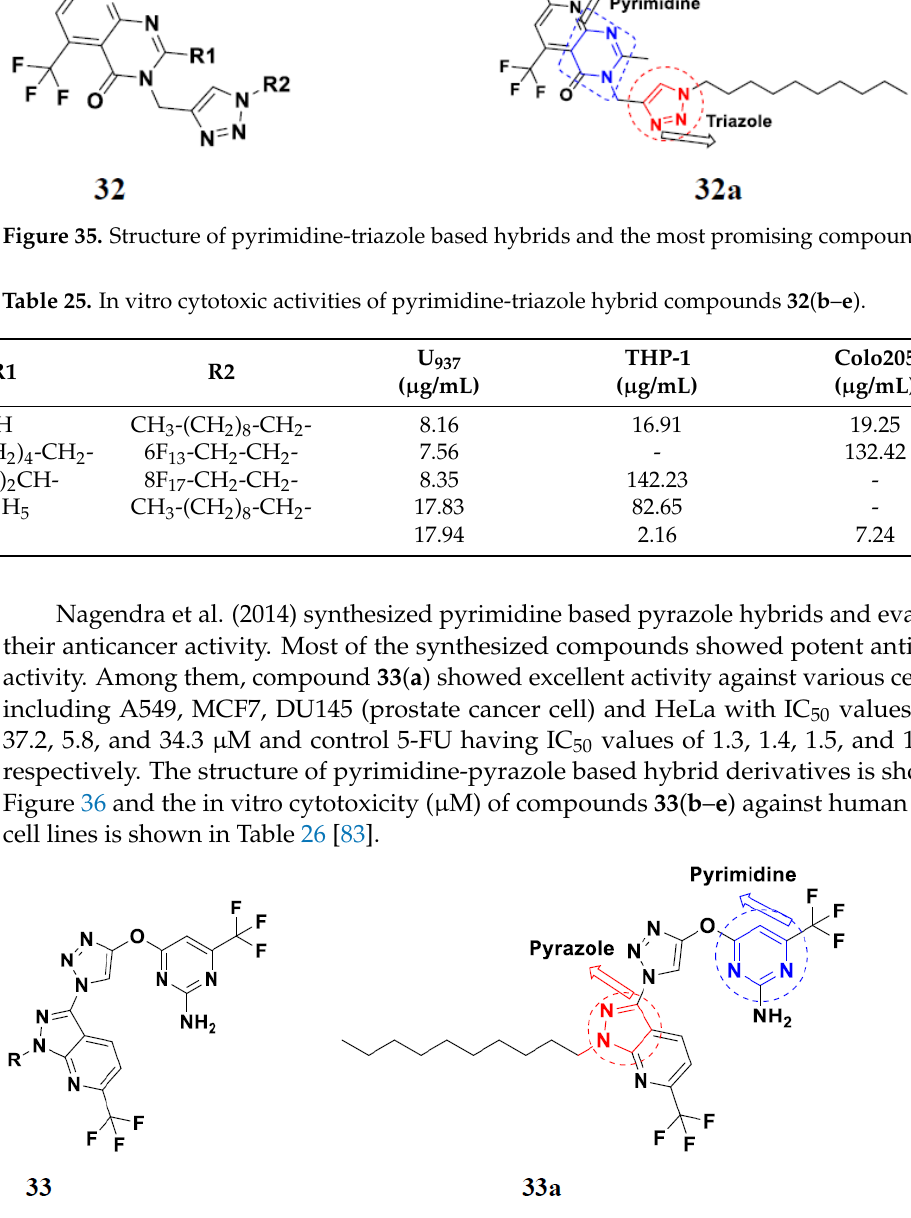
Figure 36. Structure of pyrimidine-pyrazole based hybrids and the most promising compound 33a.